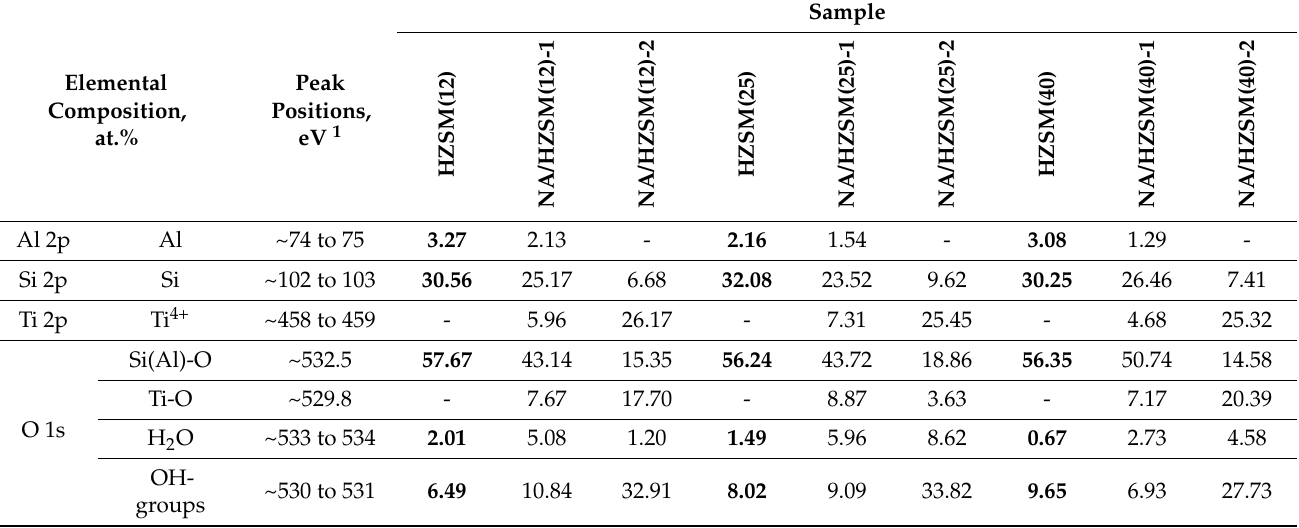
Table 5. Sample surface composition (at.%) (XPS) (data from